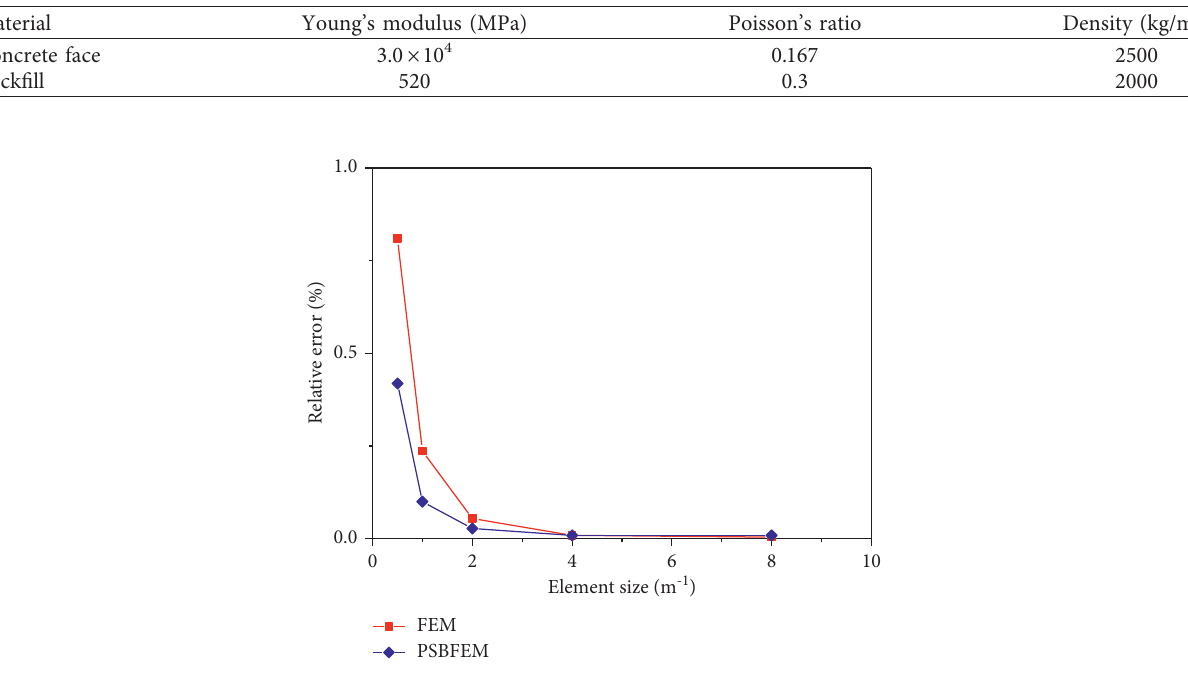
Figure 17: Sensitivity analysis of meshes.